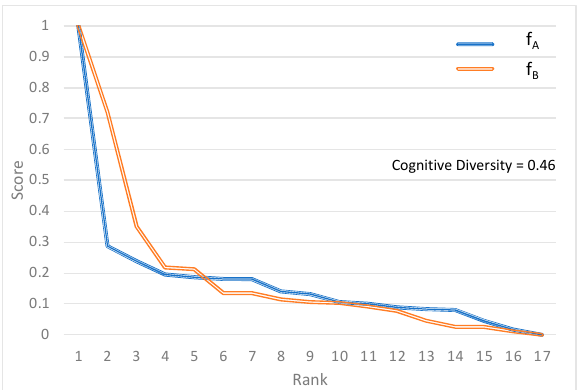
Figure 2. Rank-score functions f A and f B for median cognitive diversity case [30].